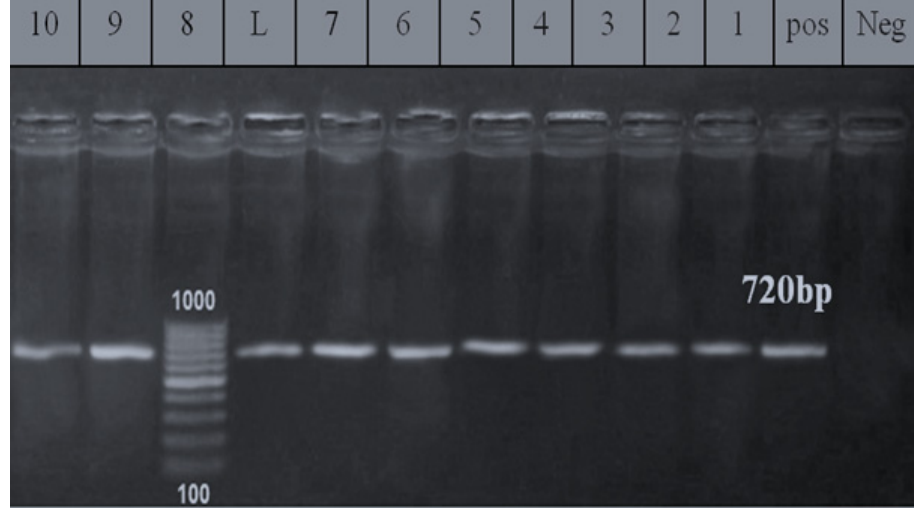
Figure 5. Agarose gel electrophoresis of phoA gene (720 bp). L: 100 bp ladder as molecular size DNA marker. Pos: Control positive for phoA gene. Neg: Control negative. Lanes from 1 to 10: Positive E. coli strains (O166, O146, O44, O111, and O26) isolated from beef shoulder and abattoir effluent for phoA gene.